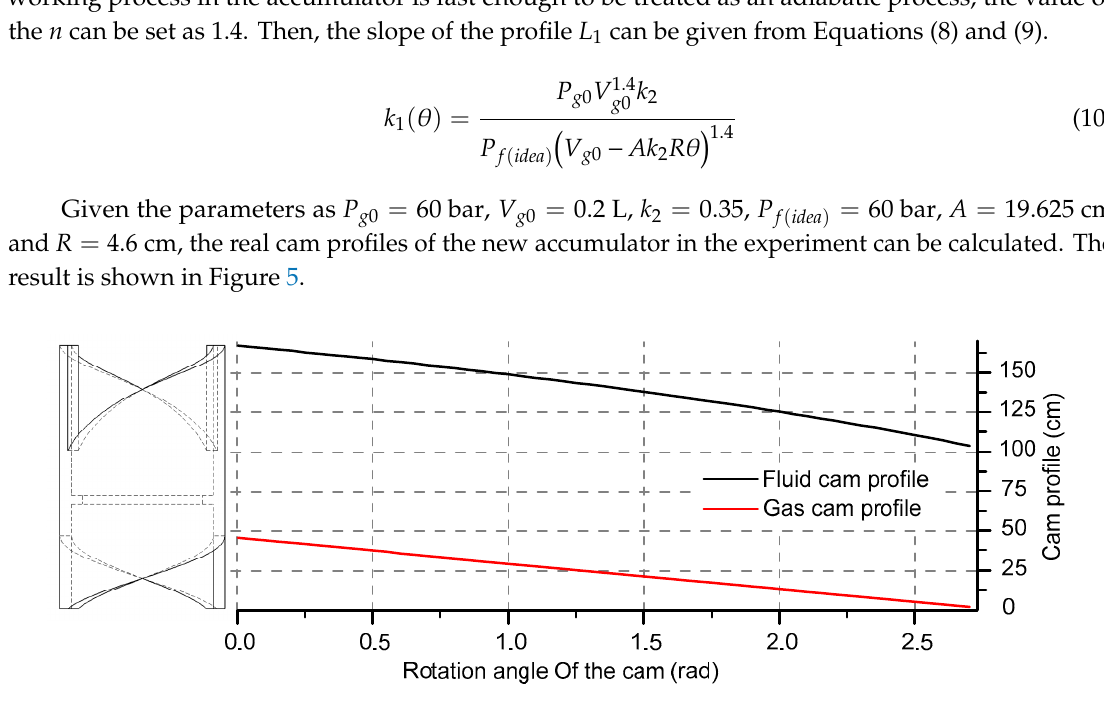
Figure 5. Real cam profiles of the new accumulator in the experiments.